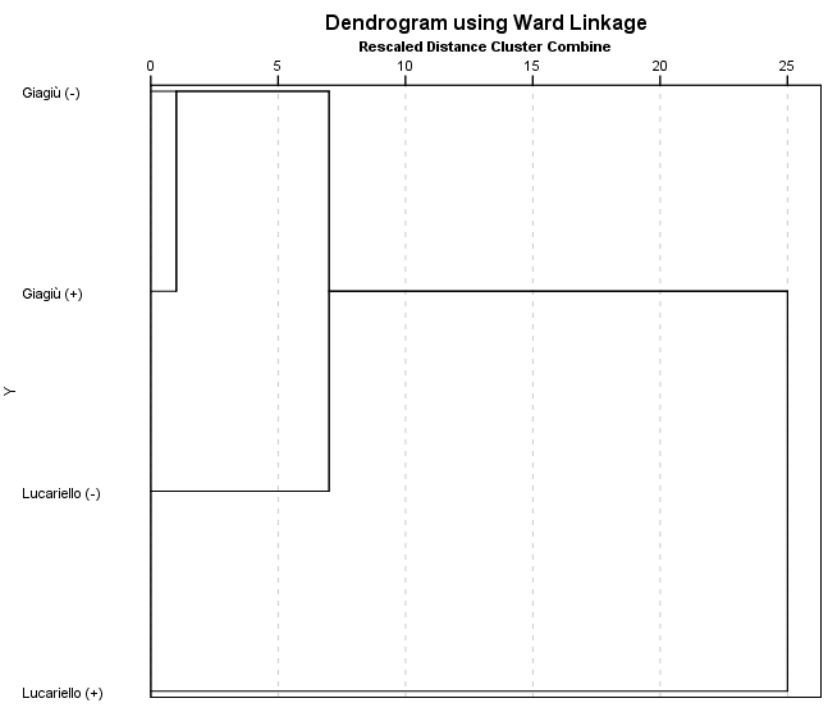
Figure 4. Hierarchical cluster analysis based on free amino acids profile and total amino acids content.